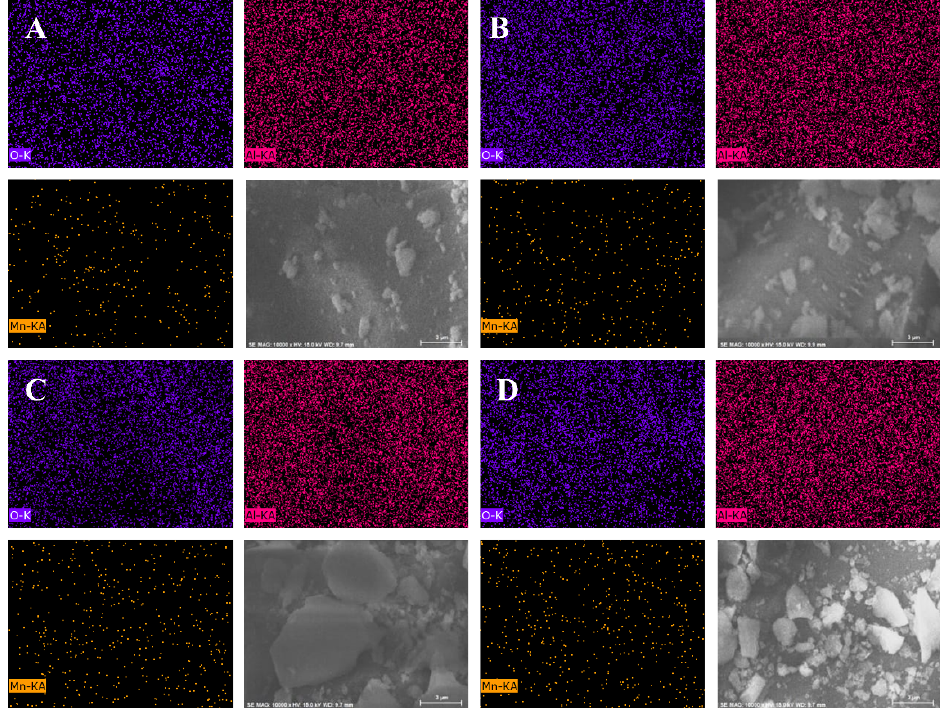
Figure 6. SEM-EDS images of ( A ) MnAlO x -450 ◦ C, ( B ) MnAlO x -550 ◦ C, ( C ) MnAlO x -700 ◦ C, ( D ) MnAlO x -800 ◦